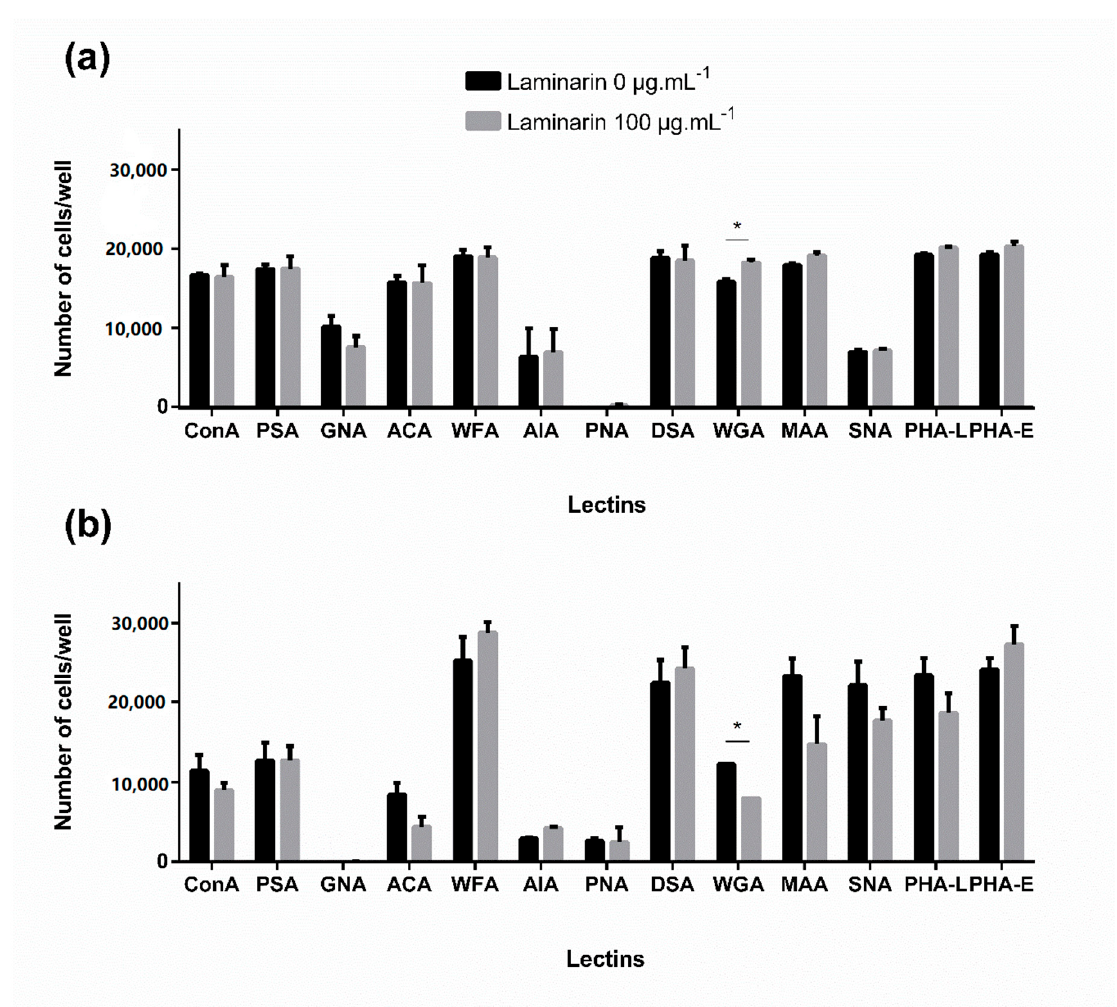
Figure 6. Effect of laminarin on lectin binding skin cell surface (GLYcoPROFILE). ( a ) HDFa and ( b ) NHEK cells were stimulated in the absence (black bar) or with 100 µg.mL − 1 (dark grey bar) of laminarin (stimulation 72 h before the analysis). Data are expressed as mean ± SD of two independent experiments. For the abbreviations of lectins, see Table 1. * p ≤ 0.05.